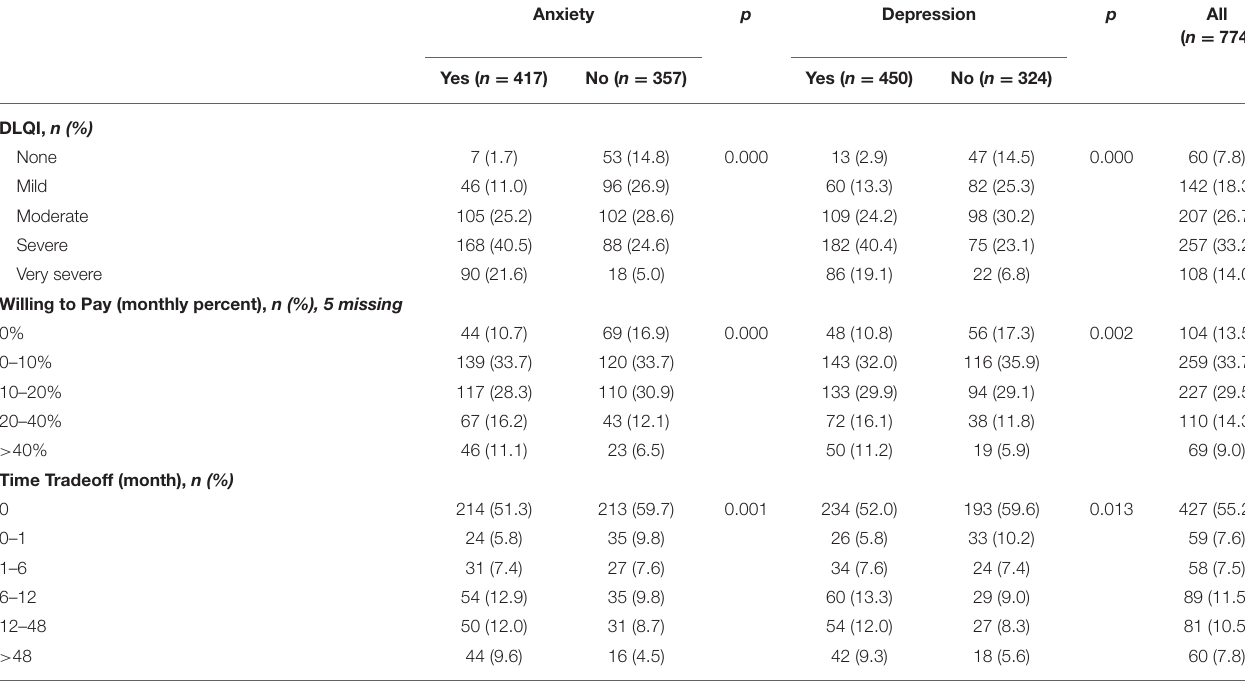
TABLE 4 | Disease burden associated with anxiety or depression.